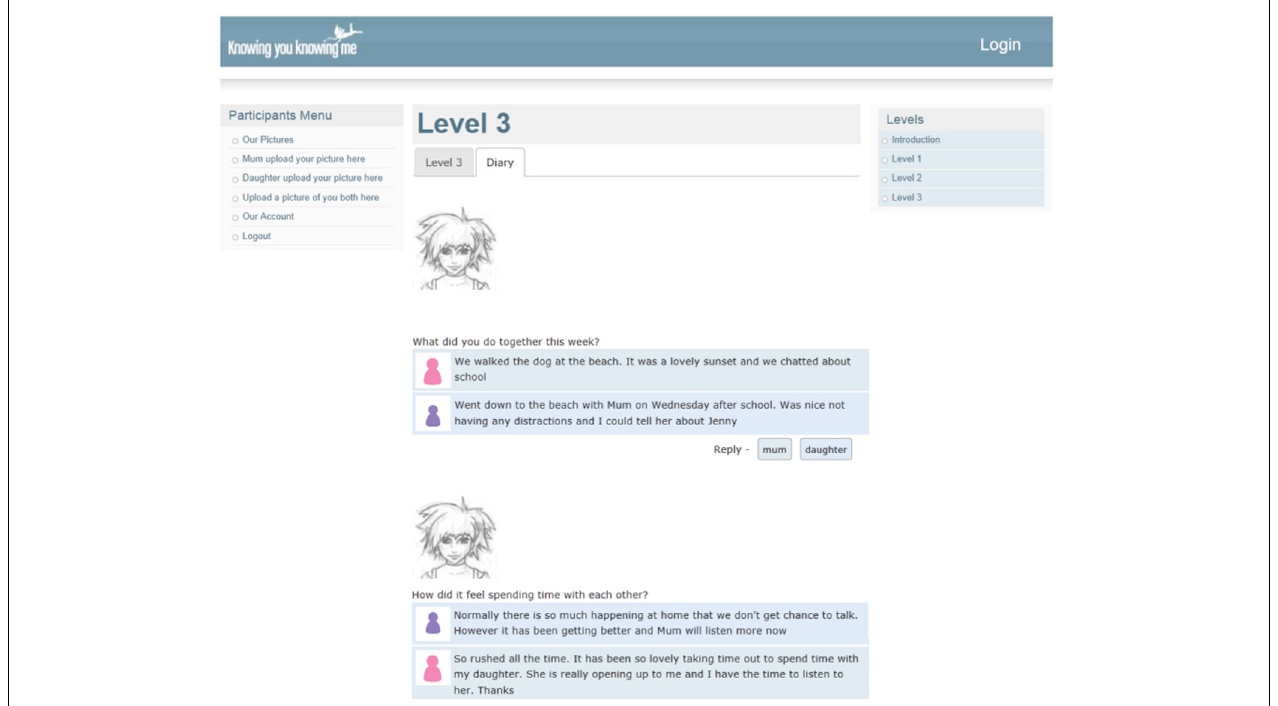
FIGURE 4 | Knowing you, Knowing me diary page with posting from mother and daughter reflecting on their experience during the week.